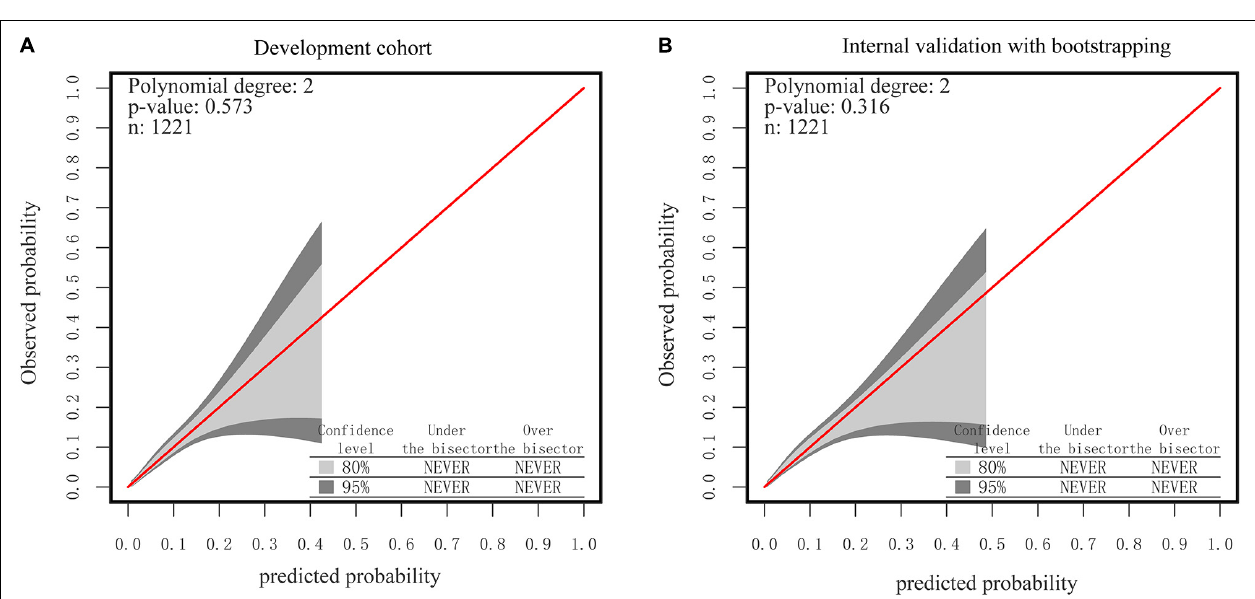
FIGURE 5 | ROC curves of the nomogram. (A) The development Cohort. (B) The internal validation cohort. The X -axis represents the false-positive rate of the risk prediction. The Y -axis meant the true-positive rate of the risk prediction.